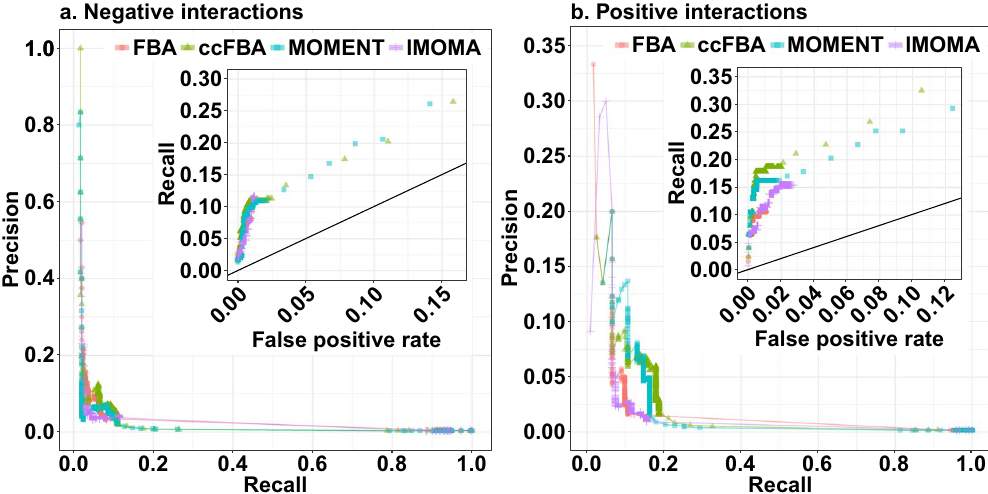
Figure 3. The accuracy of the four prediction methods for ( a ) negative and ( b ) positive epistatic interactions. The outer panels show precision (fraction of predictions that are confirmed by the experimental data) vs . recall (fraction of experimentally observed interactions that are predicted correctly), while the insets show a detail of the receiver operator characteristic (ROC) curve, tracing the dependence of recall on the false positive prediction rate (FPR = 1 – specificity, the fraction of predicted epistasis cases that are not confirmed by the experimental